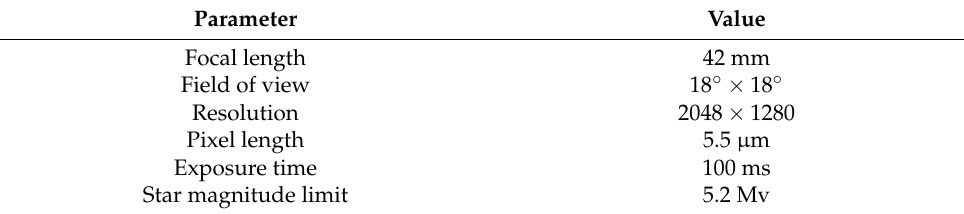
Table 1. Parameters used in